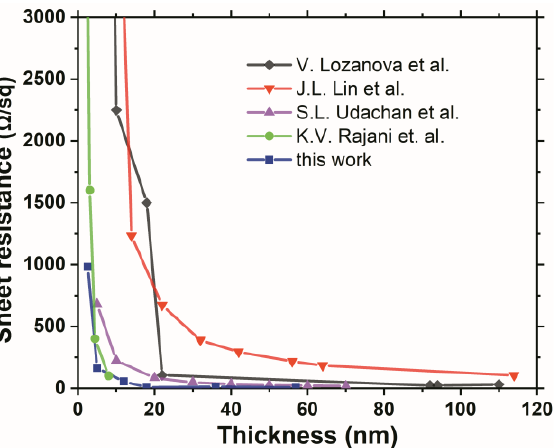
Figure 9. Sheet resistance change during the Cr film growth obtained in our experiments in com- parison with the literature data